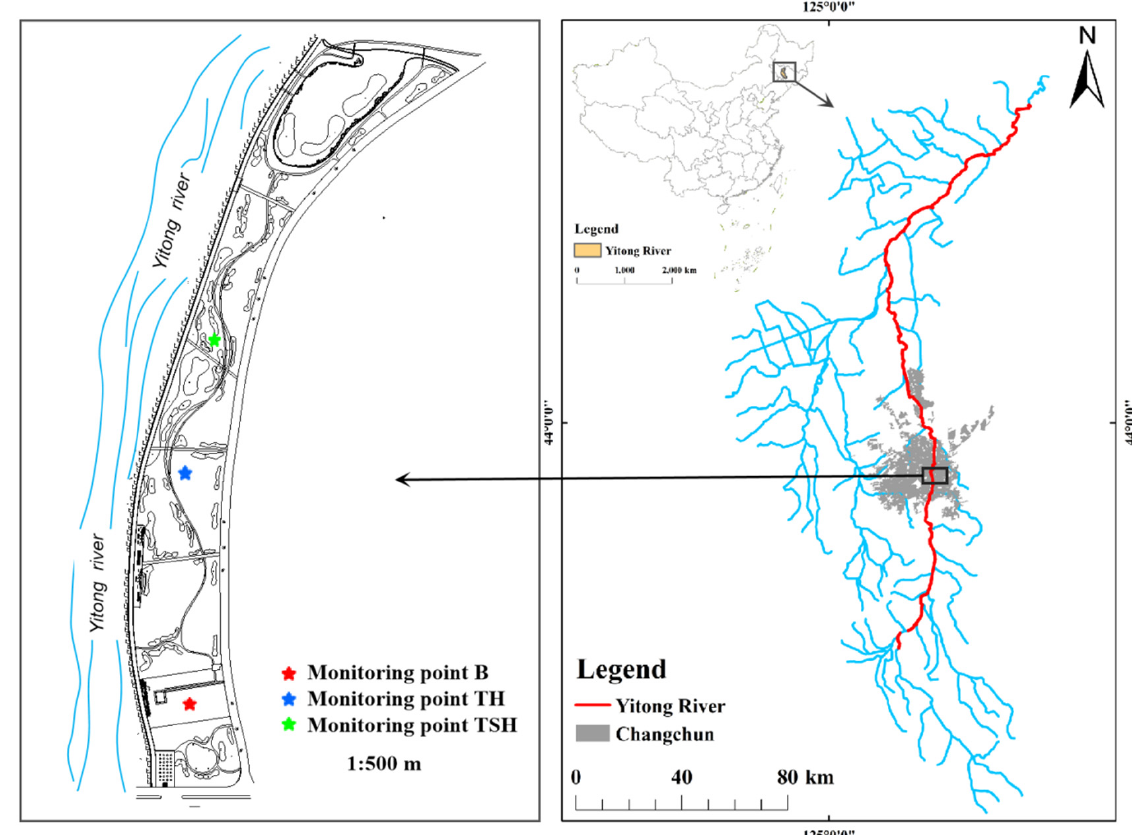
Figure 1. Location of the study area.